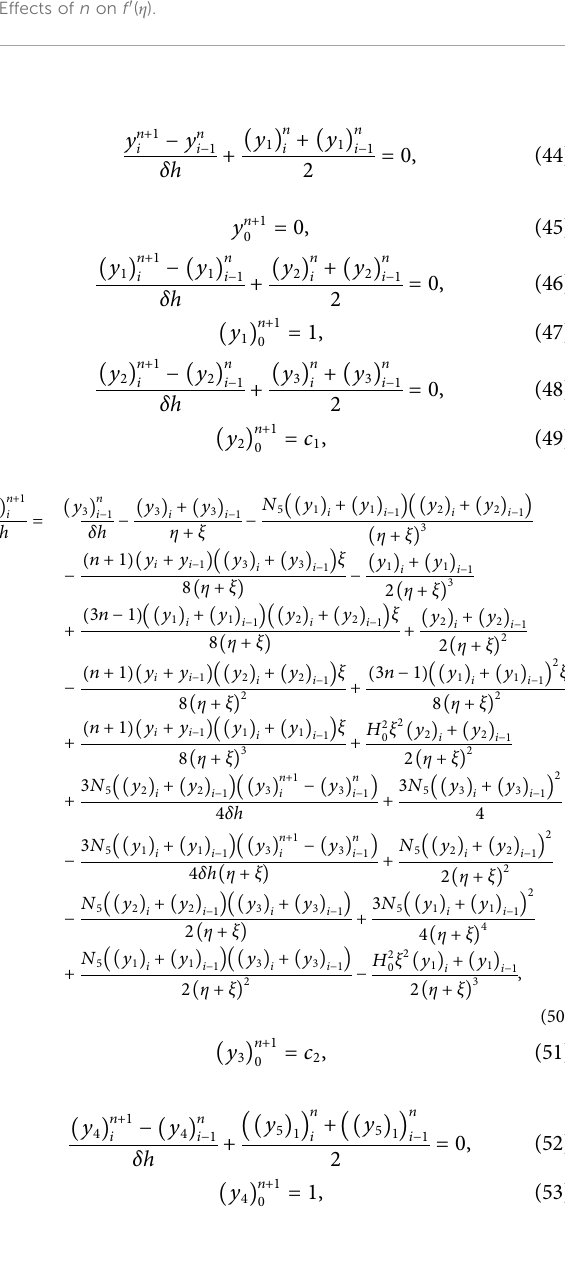
FIGURE 8 Effects of H o on f ′ ( η ).